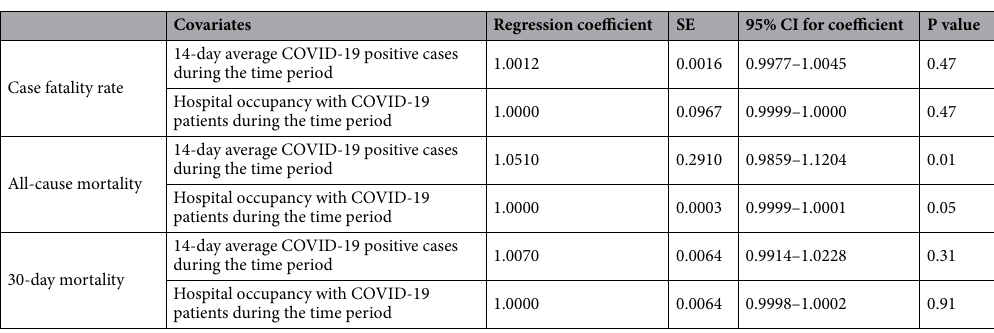
Table 4. Shows the meta-regression table for the included studies.